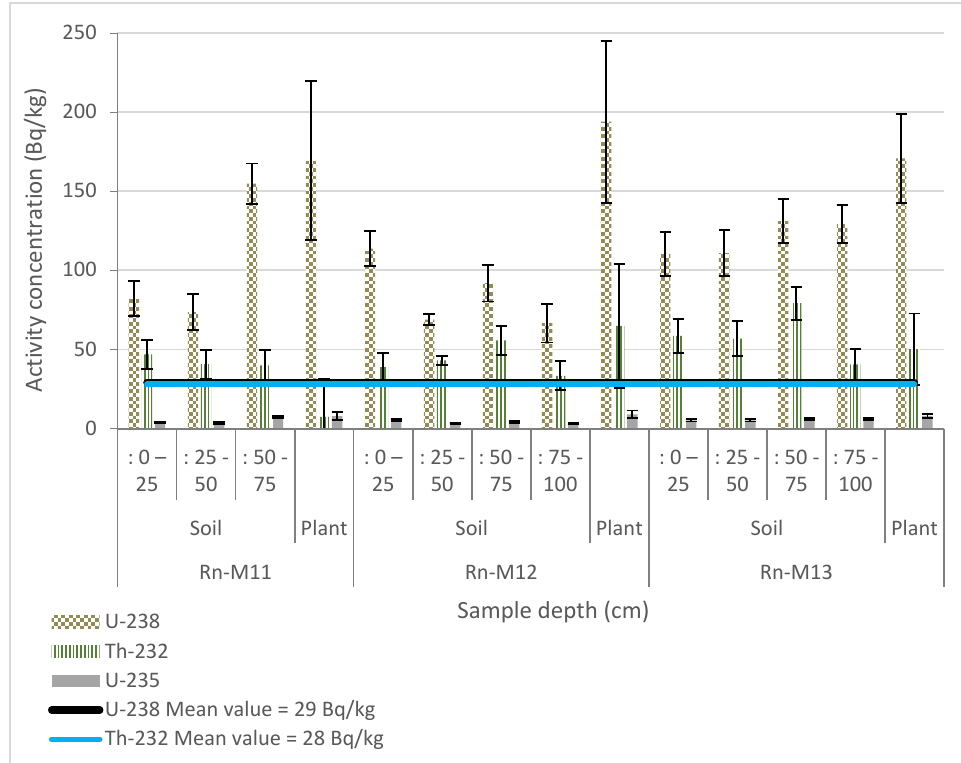
Figure 3. Activity concentrations for U-238, U-235, and Th-232 in soil and plant samples. The activity concentrations for the radioactive soil sample and washed and un- washed radioactive plant samples were compared to other samples, as illustrated sepa- rately in Figure 4. While comparing the activity concentrations for the washed and un- washed plant samples, it was noted that the concentration difference was not significant. The difference in activity concentrations for both washed and unwashed plant samples was unnoticeable.